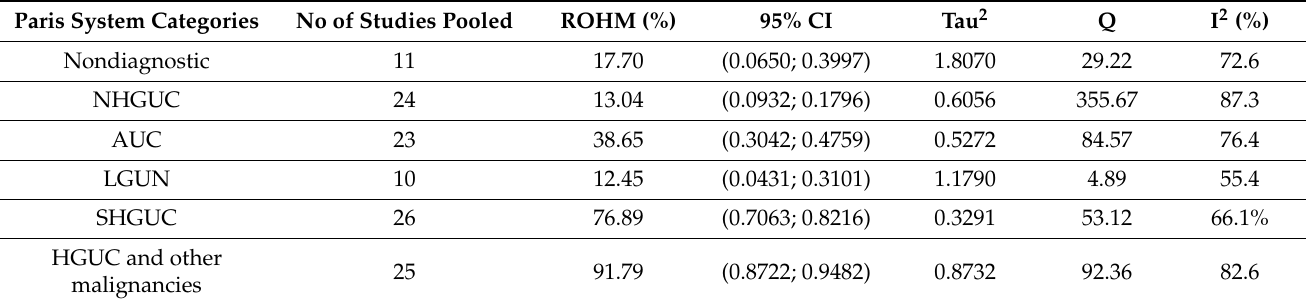
Table 2. Pooled risk of high-grade malignancy (ROHM) associated with each of the Paris System